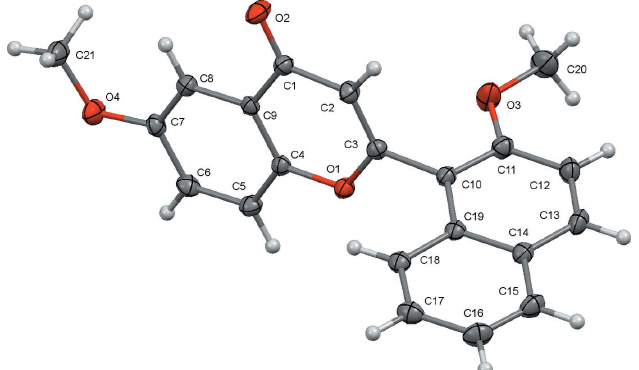
Figure 2 The molecular structure of the title compound, showing the atom- labelling scheme, with displacement ellipsoids drawn at the 30% probability level.